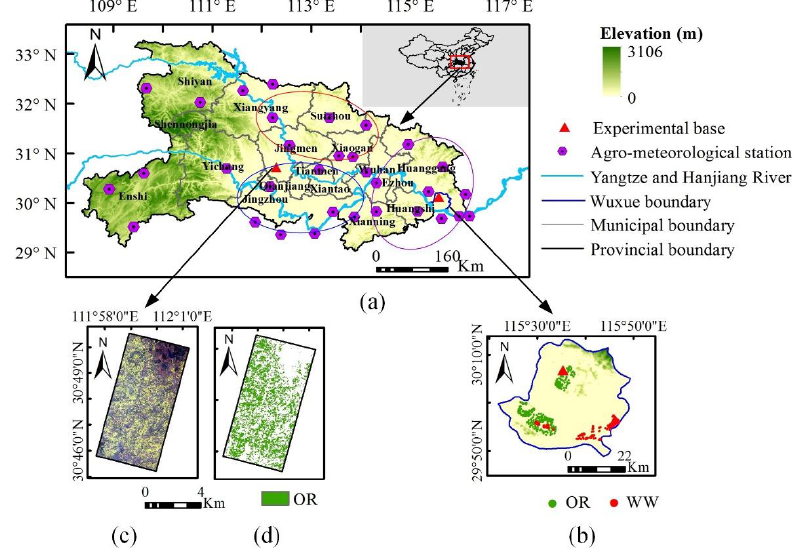
Figure 1. ( a ) Hubei Province with OR experimental base, running river, agro-meteorological station, and topography; ( b ) Wuxue City with field survey points of OR and WW; ( c ) the resized GF-2 PMS fusion image of overlap region between GF-2 PMS image and RapidEye images in Shayang County; and ( d ) the corresponding reference OR map of ( c ).